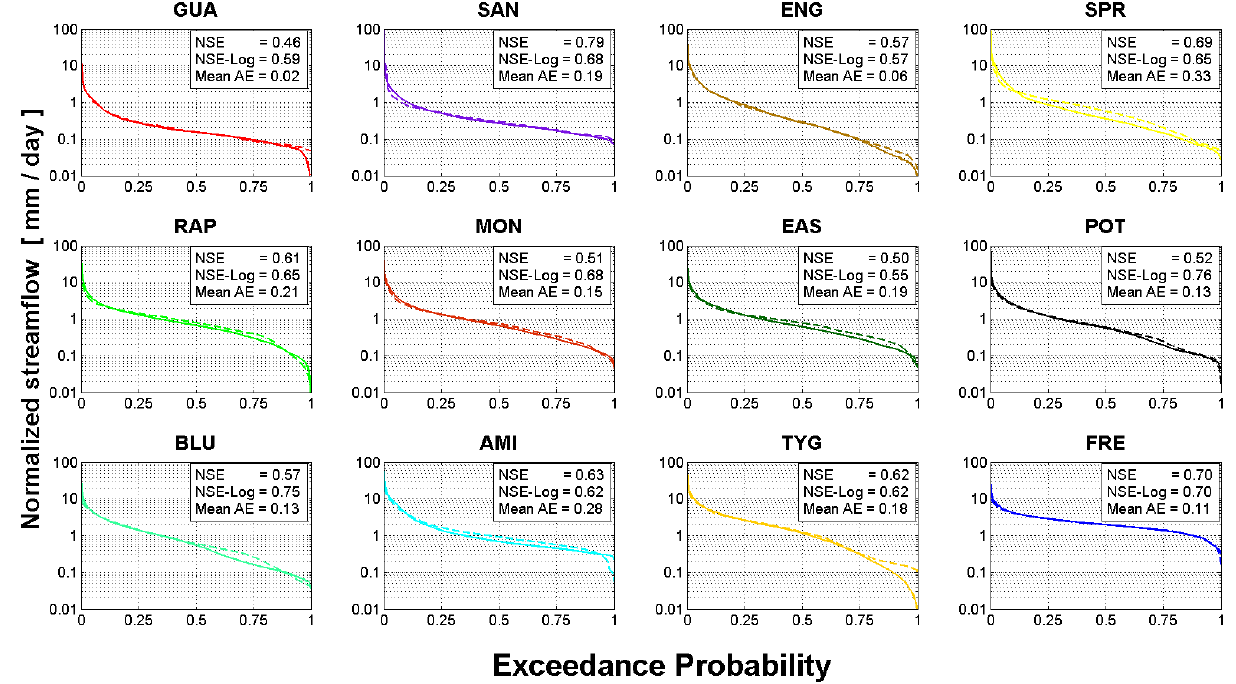
Fig. 6. Observed (solid line) versus simulated (dashed line) flow duration curves for all 12 catchments for the period 1990–1999. The inset shows the Nash-Sutcliffe efficiency (NSE), the Nash-Sutcliffe efficiency after log-transforming streamflow (NSE-Log) and the mean absolute error between observed and modeled ordinates of the FDC (Mean AE; in mm/d).